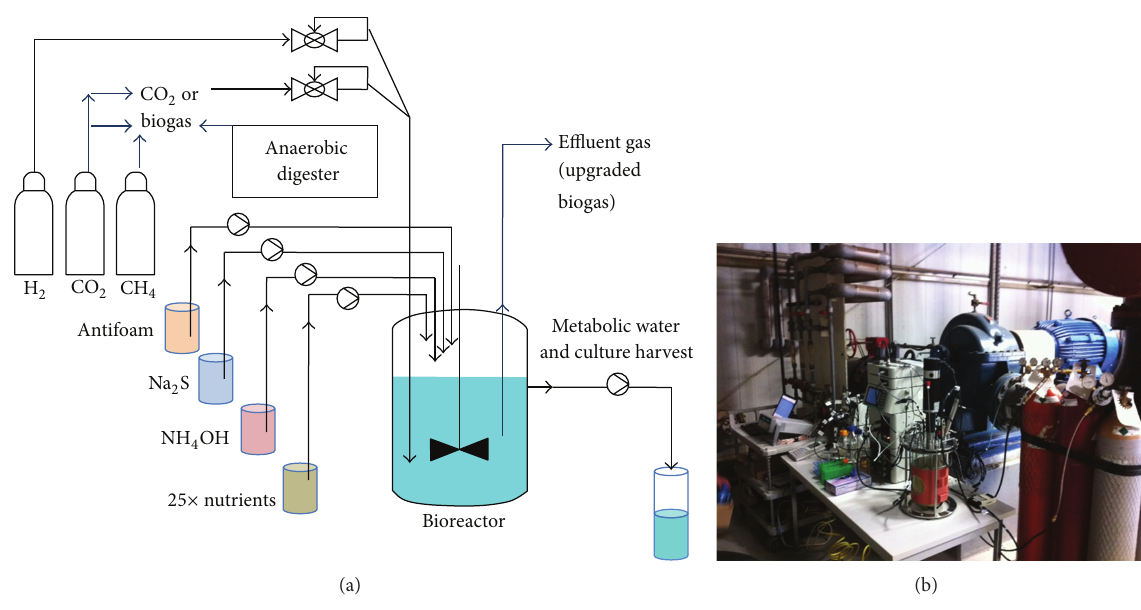
Figure 1: Schematic of the bioreactor setup (a) and view of this setup at the industrial site (b).